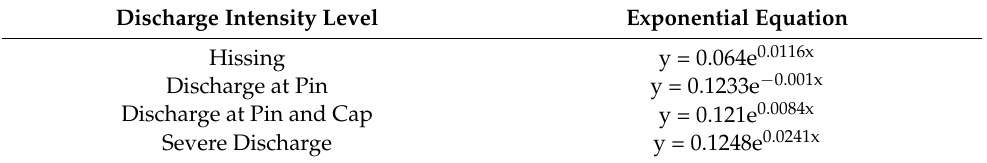
Figure 11. Average DC component for each level of discharge intensity at different insulator ages. Table 6. Exponential equation for each discharge intensity level with respect to insulator samples’